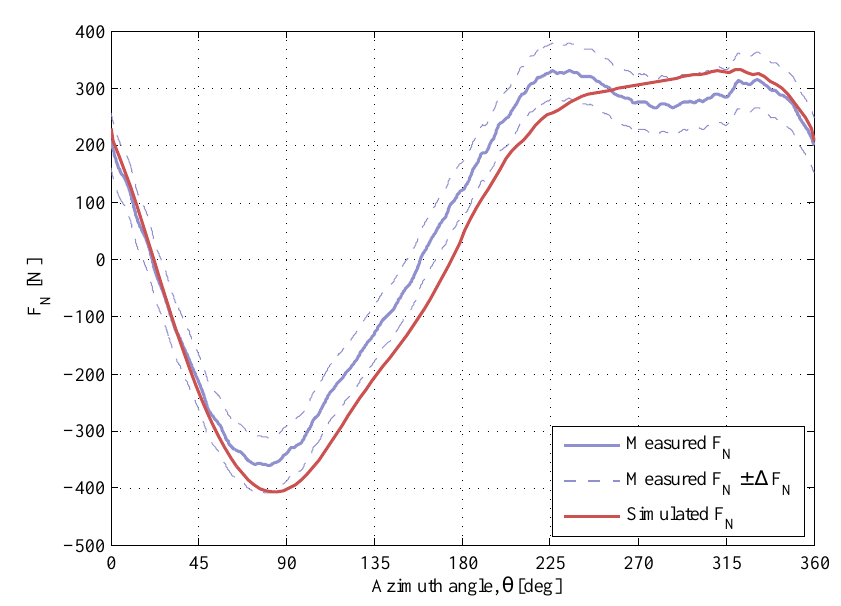
= 1 . 28 kg / m 3 , ρ = 1 . 24 kg / m 3 and ν 1 2